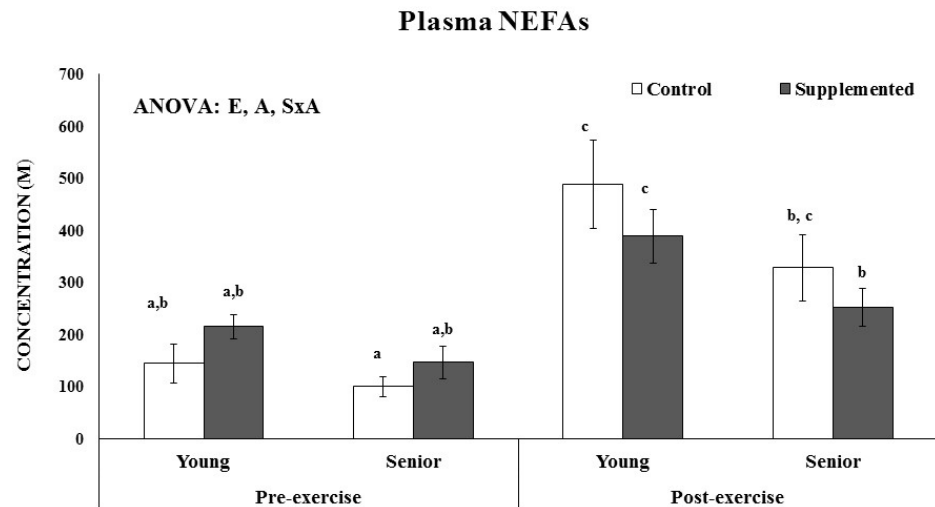
Figure 3. Age, dietary beverage supplementation and acute exercise effects on NEFAs plasma levels.